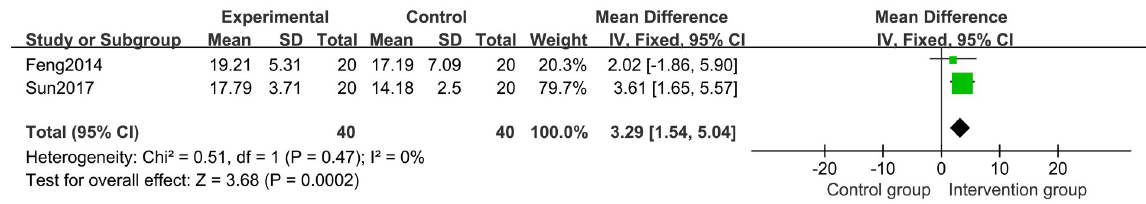
Fig 17. Forest plot of the peak level of growth hormones